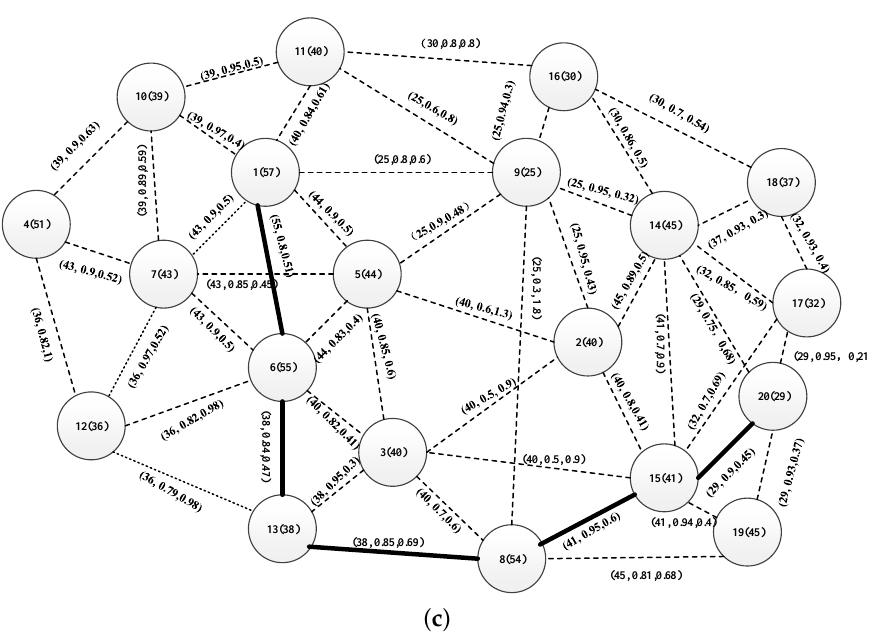
Figure 12. Grid topology ( N nodes), ω 1 = 0.4, ω 2 = 0.3, ω 3 = 0.3. ( a ) N = 10; ( b ) N = 15; ( c ) N = 20.